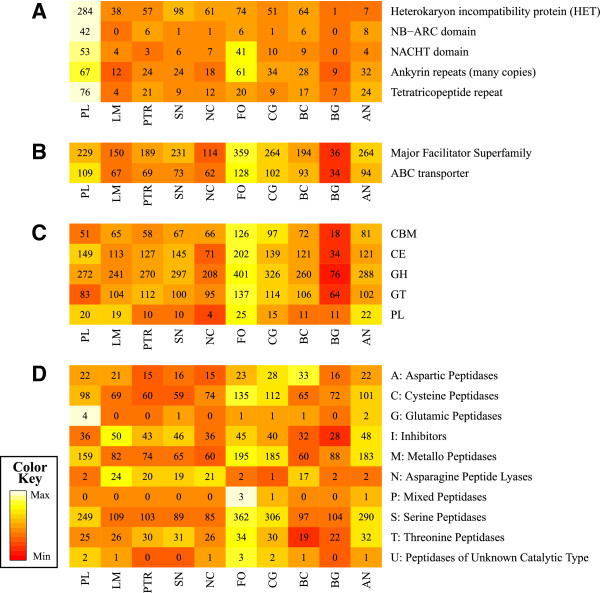
Comparison of repertoires of important fungal protein families. The heat maps compare the number of functional domains identified in P. lycopersici (PL) and nine other fungal pathogens: Aspergillus nidulans (AN), Botrytis cinerea (BC), Blumeria graminis (BG), Colletotrichum graminicola (CG), Fusarium oxysporum (FO), Leptosphaeria maculans (LM), Neurospora crassa (NC), Pyrenophora tritici-repentis (PTR) and Stagonospora nodorum (SN). A) Vegetative incompatibility-related domains. B) Virulence-related efflux pump domains. C) Carbohydrate-active enzymes (CAZymes), GH = glycoside hydrolases; GT = glycosyltransferases; PL = polysaccharide lyases; CE = carbohydrate esterases; CMB = carbohydrate-binding modules. D) Peptidases by superfamily.